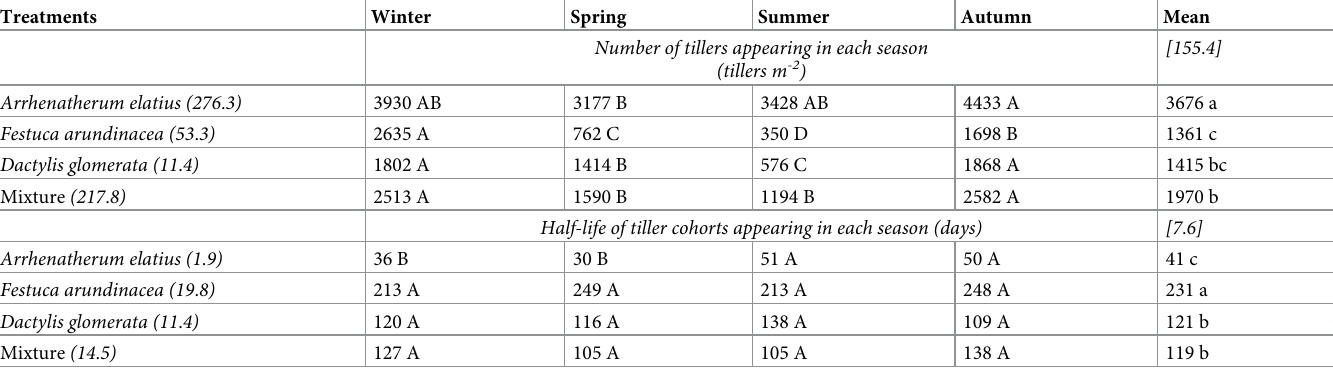
Table 3. Total number of tillers that appeared in each season and half-life of Arrhenatherum elatius , Festuca arundinacea and Dactylis glomerata swards sowed as monoculture or as a mixture throughout the seasons. Treatments